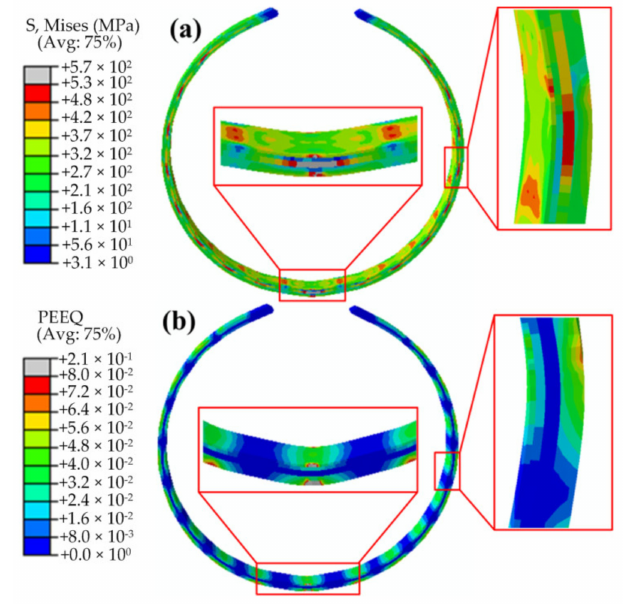
Figure 9. Mises stress and equivalent plastic strain (PEEQ) contours of the “O” forming: ( a ) Mises stress and ( b )